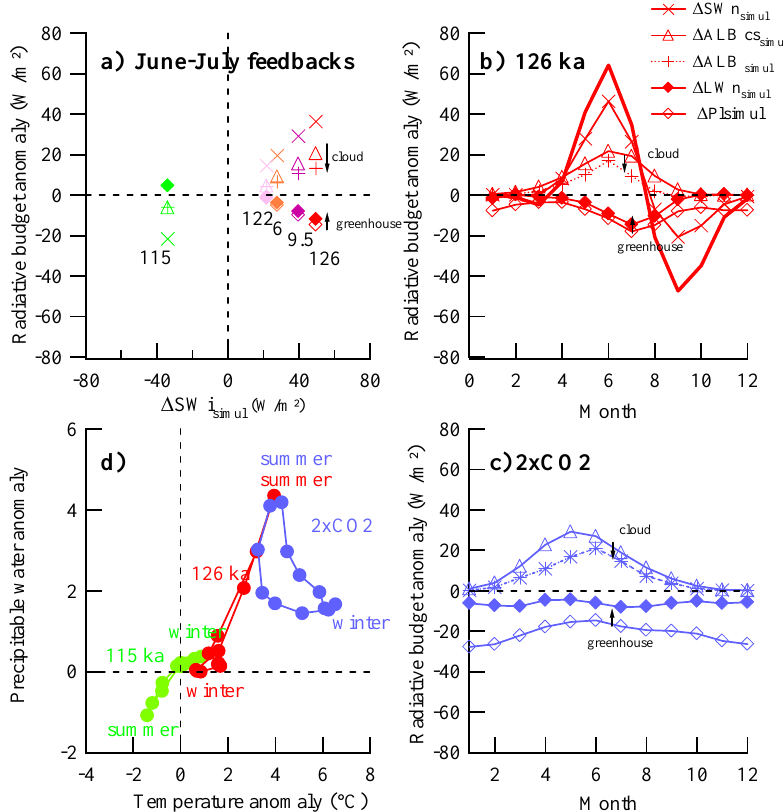
Fig. 5. Analysis of atmospheric feedbacks affecting the TOA radiative budget. (a) June–July changes in radiative budget terms (see text and figure legend for details) as a function of June-July incoming solar radiation (Wm − 2 ), for different orbital contexts (6ka, orange; 9.5ka, violet; 115ka, green; 122ka, pink; and 126ka, red). Arrows depict the magnitude of albedo (difference between “+” and triangle symbols), cloud (difference between “+” and “ x ” symbols) and greenhouse (difference between open and filled diamonds) feedbacks for 126ka. (b) Monthly values of the radiative budget 126ka anomalies with respect to the control simulation (see text and legend for details) (Wm − 2 ). (c) Same as (b) but for 2 × CO 2 . (d) Seasonal cycle of precipitable water anomaly as a function of temperature anomaly ( ◦ C) with respect to the control simulation, for 115ka (green), 126ka (red) and 2 × CO 2